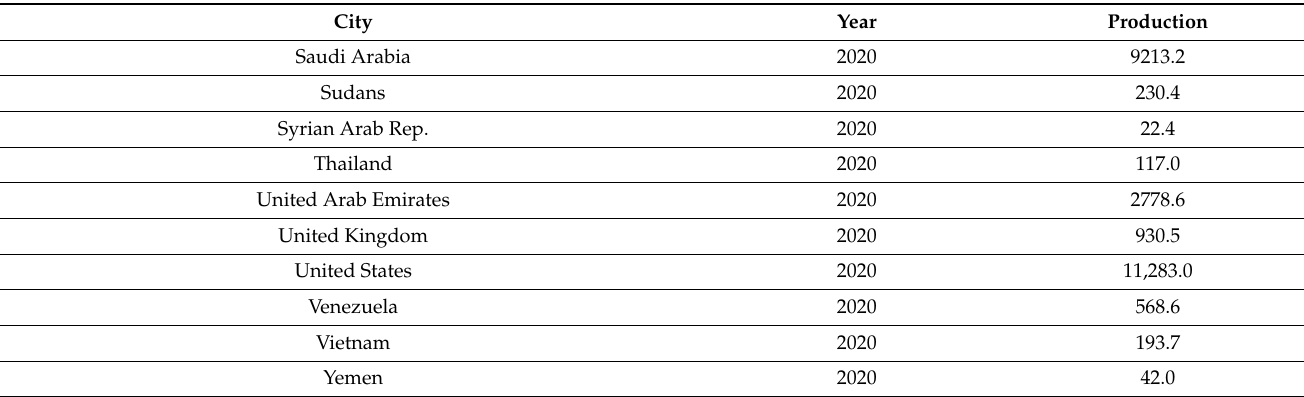
Table 2. Sample of the world crude oil production by country (1000 b/d).